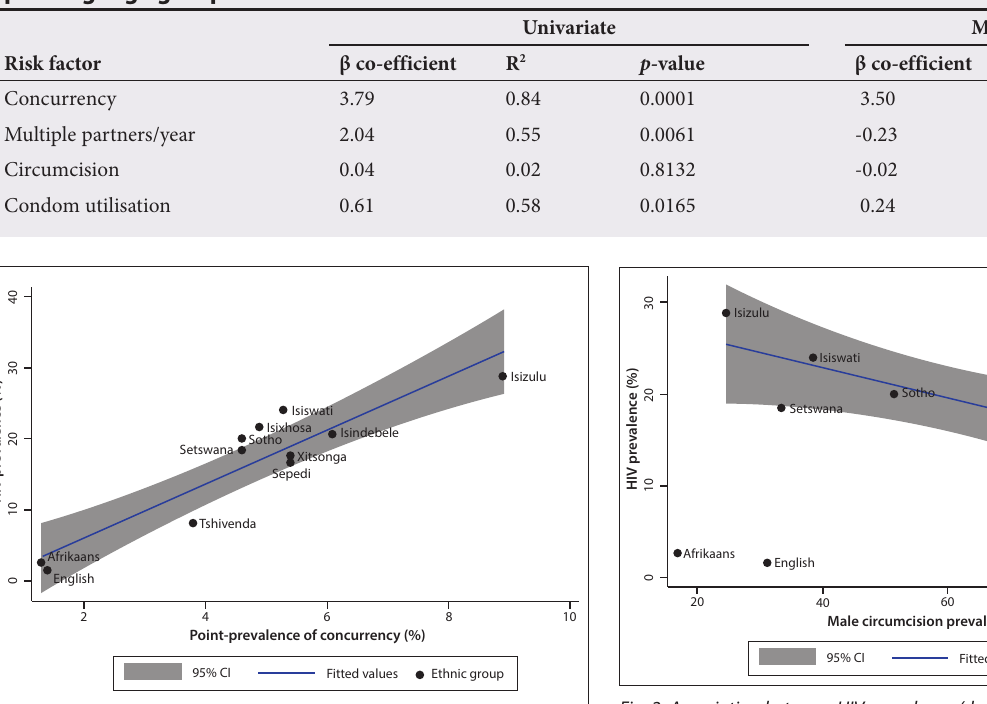
Fig. 1. Association between HIV prevalence (derived from SABSSM III) and the point prevalence of concurrency (derived from NCS 2009) for 11 language groups in South Africa ( R 2 =-0.84; p < 0.001). [2,3]